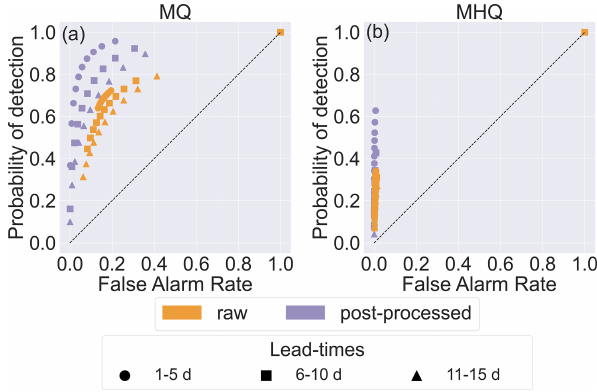
Figure 7. Relative operating characteristic diagrams for (a) the MQ threshold (118888 observations above MQ) and (b) the MHQ threshold (2783 observations above MHQ). All stations are com- bined and groupings of lead times are used (see Sect.